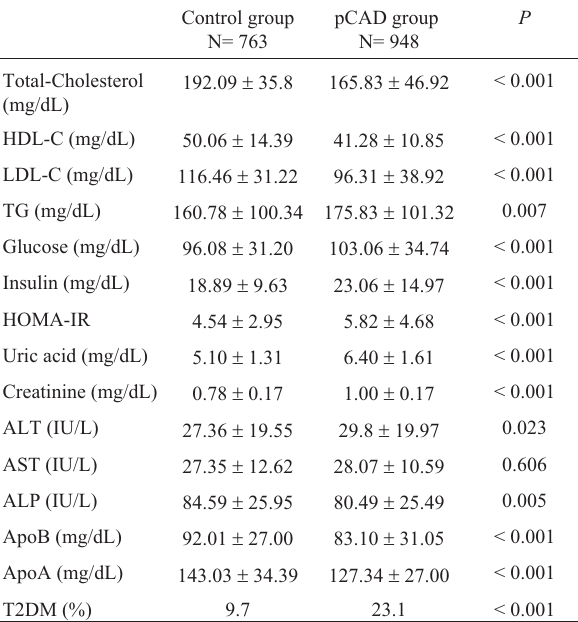
Table 2 - Metabolic characteristics of the study population